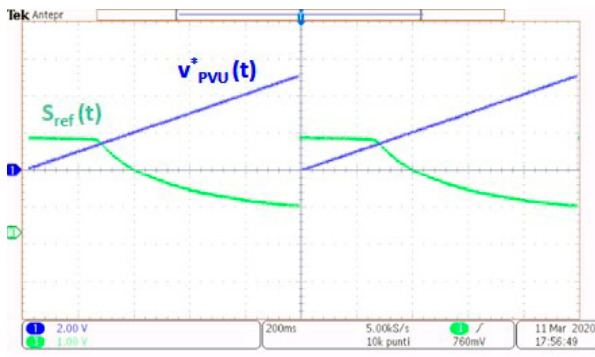
Figure 11. Oscilloscope screenshot ( S = 200 W / m 2 , T = 57.5 ◦ C, and V dsmax = 100 Figure 11. Oscilloscope screenshot ( 𝑆 = 200 W/m 2 , 𝑇 = 57.5 °C , and 𝑉 (cid:3031)(cid:3046)(cid:3040)(cid:3028)(cid:3051) = 100 V). Figure 11. Oscilloscope screenshot ( 𝑆 = 200 W/m 2 , 𝑇 = 57.5 °C , and 𝑉 (cid:3031)(cid:3046)(cid:3040)(cid:3028)(cid:3051) = 100 V).